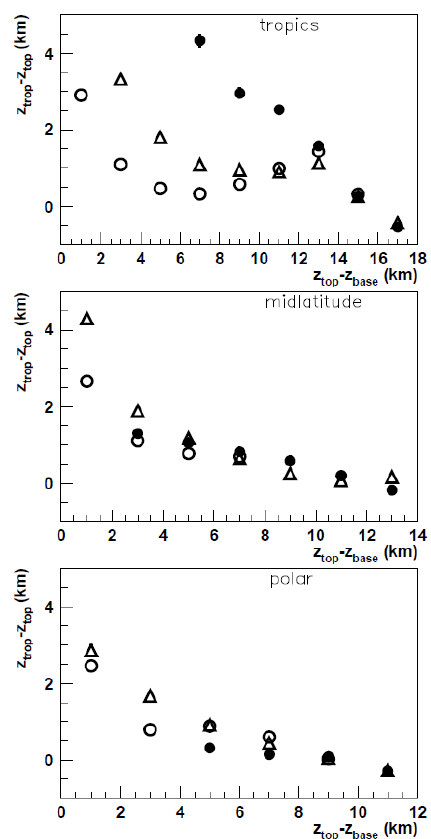
Figure 14: Average difference between the height of the tropopause and the cloud top as a function of Fig. 14. Average difference between the height of the tropopause real cloud geometrical thickness, separately for high opaque clouds (full circles), cirrus (open triangles) and the cloud top as a function of real cloud geometrical thick- and thin cirrus (open circles) and for three different latitude bands: 30°N-30°S (upper panel), 30°-60° ness, separately for high opaque clouds (full circles), cirrus (open (middle panel) and 60°-90° (lower panel). triangles) and thin cirrus (open circles) and for three different lat- itude bands: 30 ◦ N–30 ◦ S (upper panel), 30 ◦ –60 ◦ (middle panel) and 60 ◦ –90 ◦ (lower